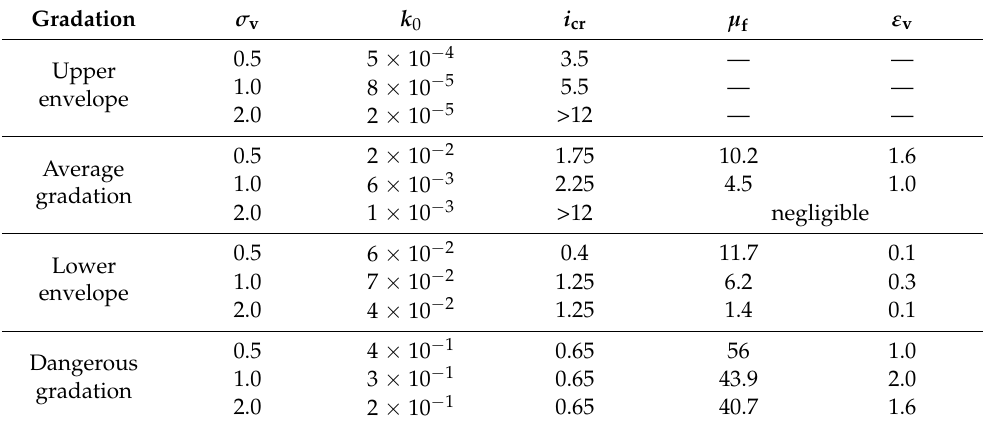
Table 2. Summary of the tests conducted and typical